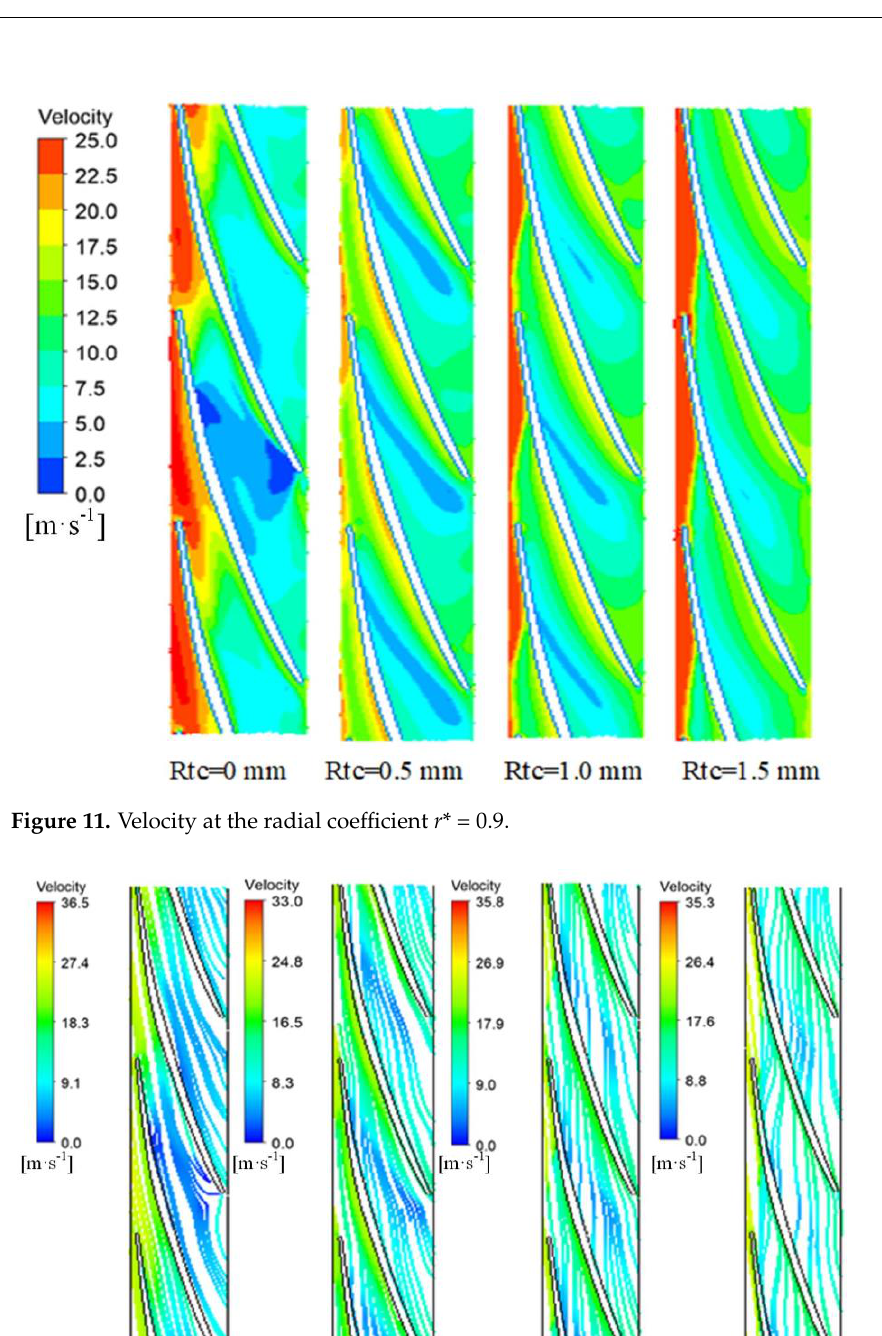
Figure 10. Pressure on the radial coefficient r * = 0.9.